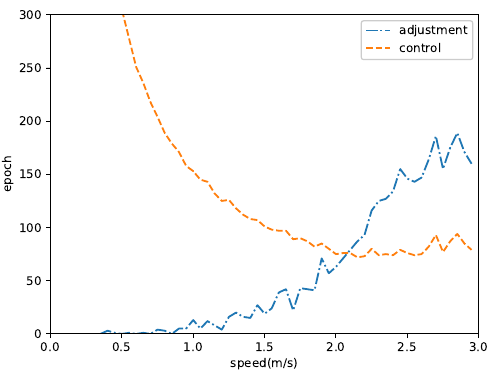
Figure 12. Position adjusting